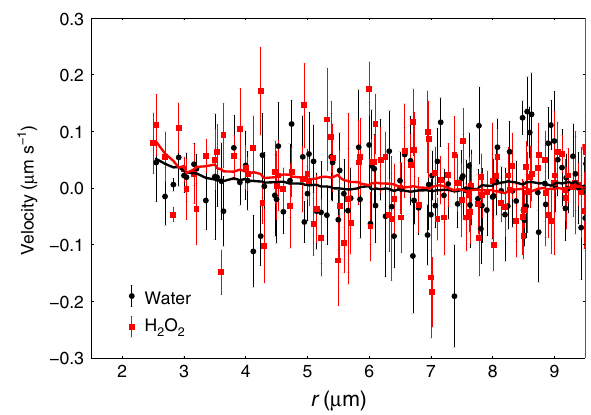
Fig. 3 Phoretic contribution to tracer motion. Comparison of the radially averaged velocities of tracer particles as a function of radial distance from the centre of a stuck symmetrically Pt-coated colloid in water, and in 10% H 2 O 2 . The solid lines are adjacent averages with a window of 5 points to aid the